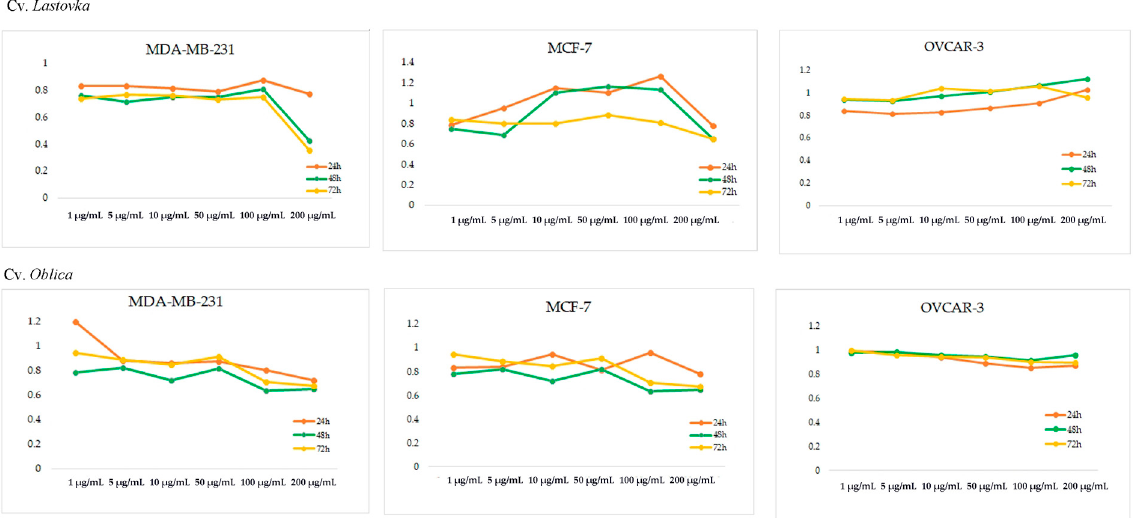
Figure 2. Percentage of metabolically active human breast adenocarcinoma (MDA-MB-231), human breast metastatic adenocarcinoma (MCF7), and human ovarian carcinoma (OVCAR-3) cell lines after 24 h, 48 h, and 72 h of incubation with different concentrations of olive bud extract from cvs. Lastovka and Oblica .